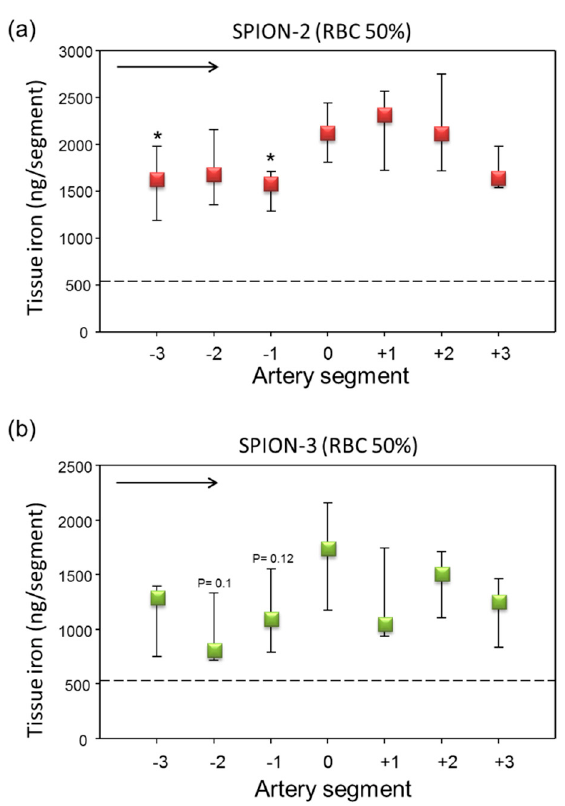
Figure 6. Magnetic targeting of circulating SPION-2 and SPION-3 in RBC suspensions at 50% Ht. ( a ) SPION-2 and ( b ) SPION-3 suspensions at 30 μ g Fe/mL were circulated in the model for 30 min under external magnetic force positioned at segment 0. Arrow indicates the direction of flow. Shown is iron concentration of respective segments (median with 75th and 25th percentile of n = 5 experiments). Average control values (SPIONs suspensions without magnet) are indicated by dashed line. * P < 0.05 versus segment 0; trend P values are indicated.